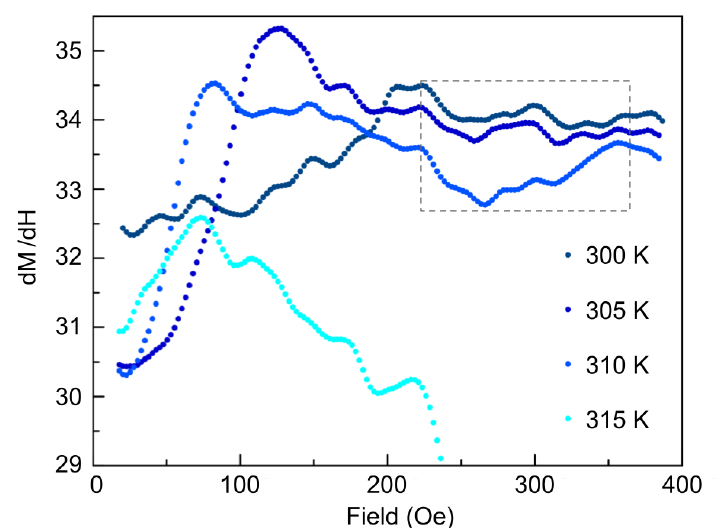
Figure 6. Temperature-dependent isothermal differential magnetic susceptibility upon increasing magnetic fields from 0 Oe to 400 Oe. Low–high temperature corresponds to dark blue–light blue curves. The dip structure (region contained within the rectangular dotted box) is most clearly pronounced for 310 K and presents at a field of ∼ 200 Oe, indicating the onset of the skyrmion